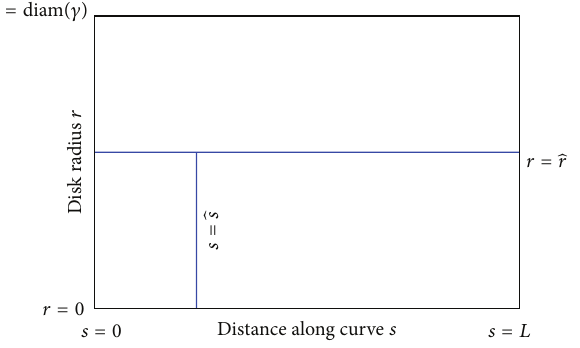
Figure 10: T-like data: we restrict the domain of 𝑔(𝑠,𝑟) to a fixed radius ̂𝑟 plus any vertical segment from 𝑟 = 0 to 𝑟 = ̂𝑟